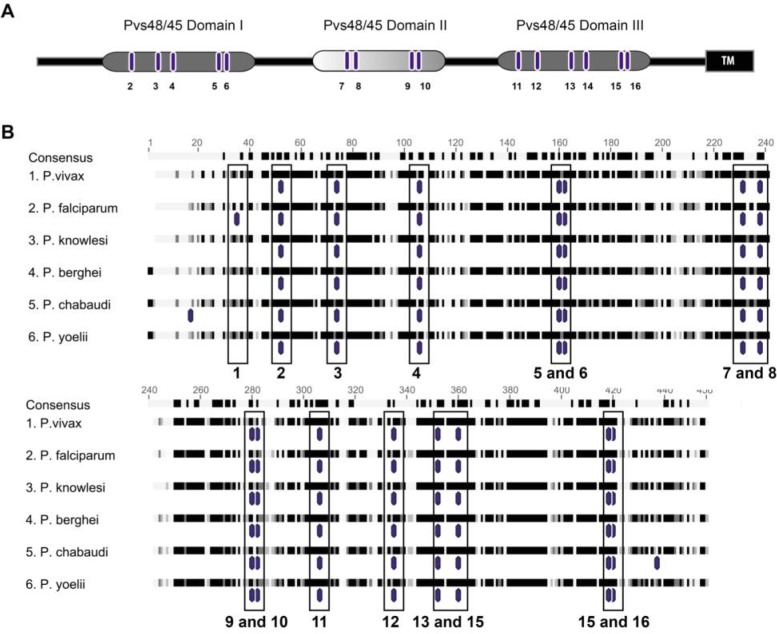
Schematic diagram and amino acid sequence alignment of Pvs48/45 protein.
A. Schematic diagram of Pvs48/45; boxes in grey represent the three P48/45 domains and the black box at the C-terminal region represents the trans-membrane domain. B. Multiple alignments between primary sequences of P48/45 proteins using the software Geneious. Conserved regions are represented in black. Cysteines are shown in blue.